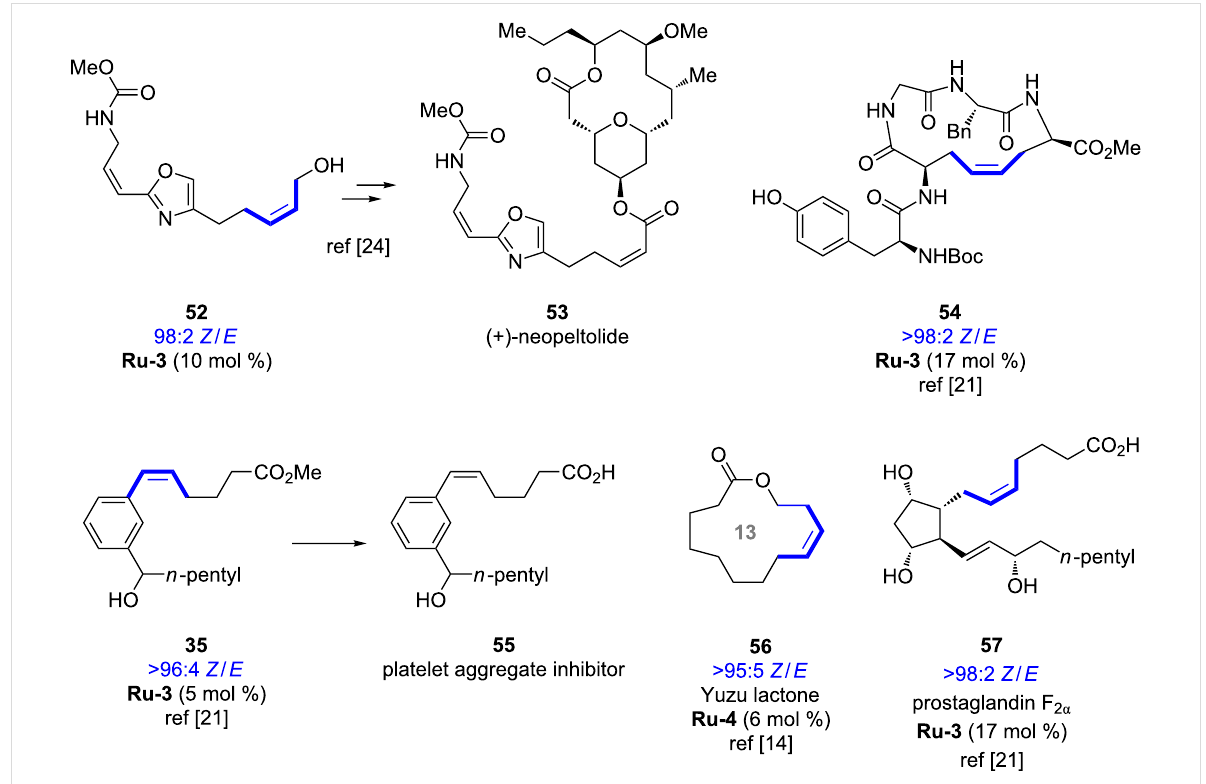
Figure 6: Examples of biologically active and fragrance molecules synthesized by stereoretentive metathesis.